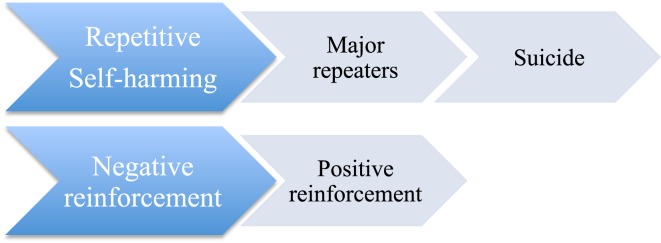
Putative transition from repetitive NSSI to repetitive SB and the mechanisms involved.